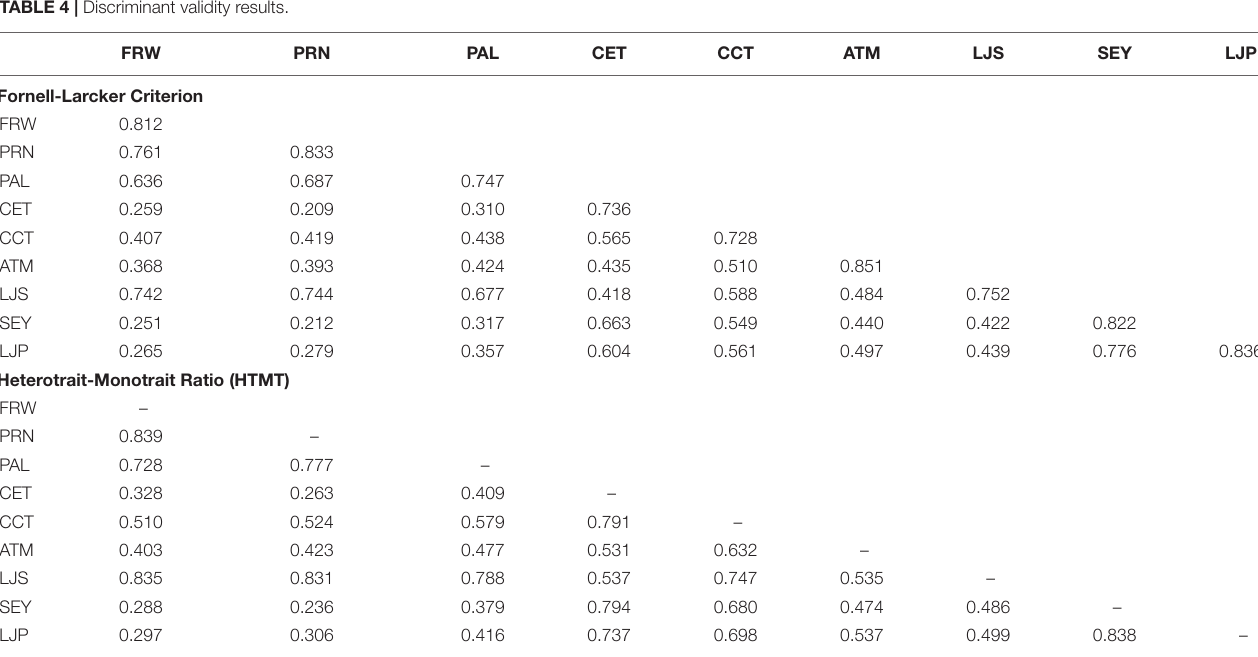
TABLE 4 | Discriminant validity